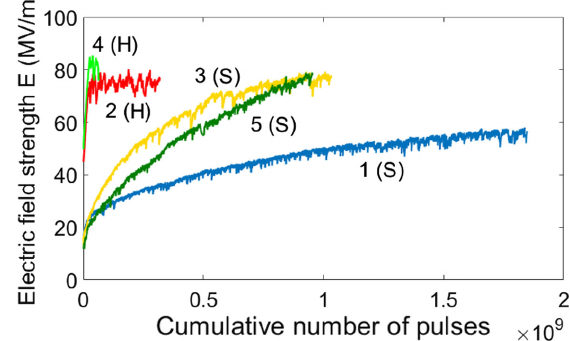
FIG. 2. Electrode surface electric field strength over the course of all five measurement runs, determined by dividing the applied voltage with the gap distance of 60 μ m. Series are labeled in the figure by sample number and type, (H)ard and